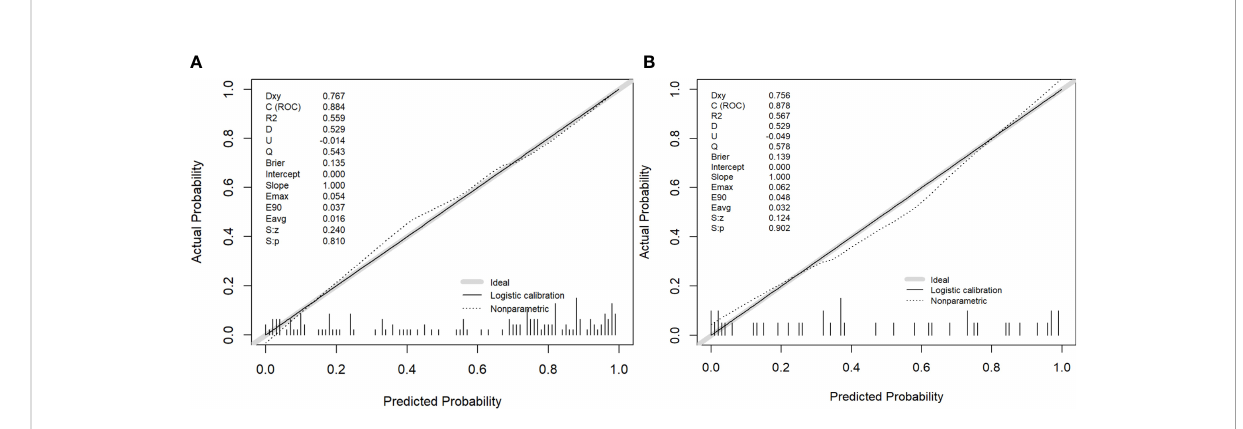
FIGURE 4 The performance of the nomogram was assessed by calibration curves in the training and validation cohort (A, B) , respectively. The y-axis represents the actual microvascular invasion (MVI) rate, the x-axis represents the predicted MVI possibility, and the diagonal dashed line indicates the ideal prediction by a perfect